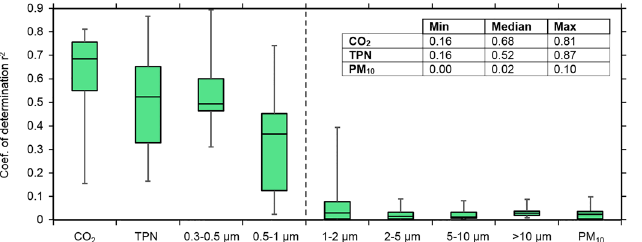
Fig 3. Coefficient of determination between baby room and hallway CO 2 levels, total particle number (TPN), size-specific PN concentrations and PM 10 mass. The results are obtained based on 5-min mean concentrations. Box plots indicate minimum, 1 st quartile, median, 3 rd quartile and maximum values considering data from the whole monitoring campaign.